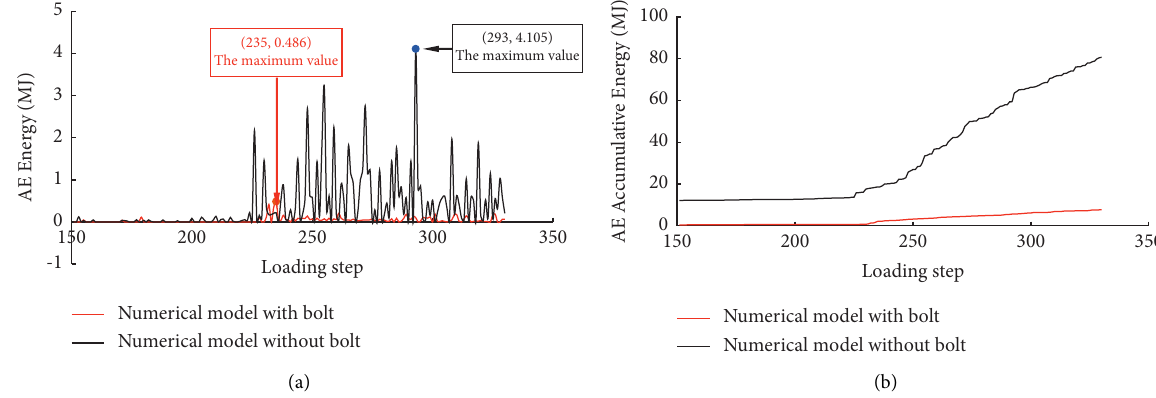
Figure 7: AE energy curve comparison of the two numerical models with bolt and without bolt. (a) AE energy. (b) AE accumulated energy.